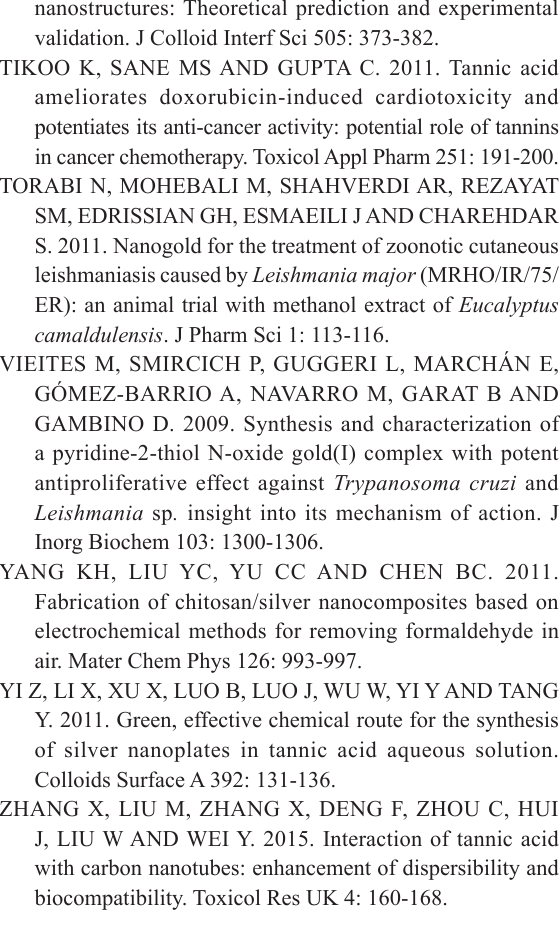
Figure S1 - UV-Vis electronic spectra for aqueous solutions of HAuCl 0.7 mmol·L -1 , AgNO 5.89 mmol·L -1 , TA 0.2 mmol·L -1 4 3 and citrate 20 mmol·L -1 . Figure S2 - UV-Vis electronic spectra for colloidal dispersions of bare nanoparticles. Inset: Tyndall effect observed for each dispersion. Figure S3 - Effect of ( a ) AgNPs-TA and ( b ) TA against L. amazonensis promastigotes at different concentrations. Value expressed as mean ± standard error, *** p < 0.0001. Figure S4 - Inhibitory effect of AgNPs on L. amazonensis promastigotes. Value expressed as mean ± standard error, *** p < 0.0001. Figure S5 - Optical microscopy views of parasite cultures ( a ) in control group (abscence of nanoparticles), ( b ) exposed to AuNPs, and ( c ) exposed to AgNPs. Quick panoptic staining and 100x magnification. Figure S6 - Effect of AgNPs on viability of murine peritoneal macrophages. Value expressed as mean ± standard error, *** p <